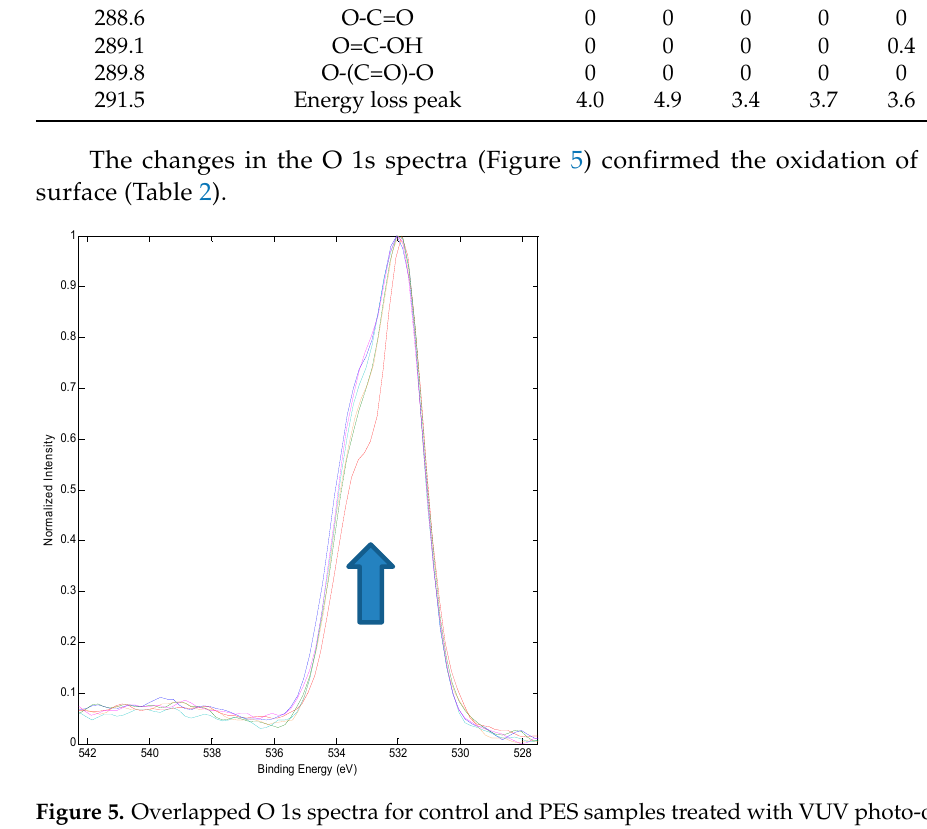
Figure 6. Overlapped S 2p spectra for control and PES samples treated with VUV photo-oxidation for 0, 5, 10, 15, 30, and 60 min. Due to the small changes in S chemical states (Table 3), an arrow indicating increasing treatment time was not possible in this Figure.